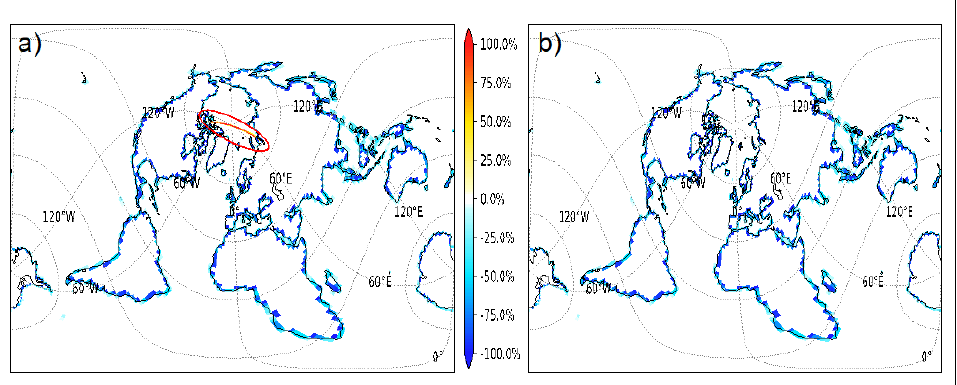
Figure 12. Two-dimensional plot of the misfit of the harmonic function regridded with ESMF first-order conservative remapping for nogt-bggd with nogt described ( a ) with the SCRIP format and ( b ) with the unstructured format. The red oval shape identifies in ( a ) the grid points linked to the north fold of the NEMO grid showing anomalous misfit when the nogt grid is described in the SCRIP format.